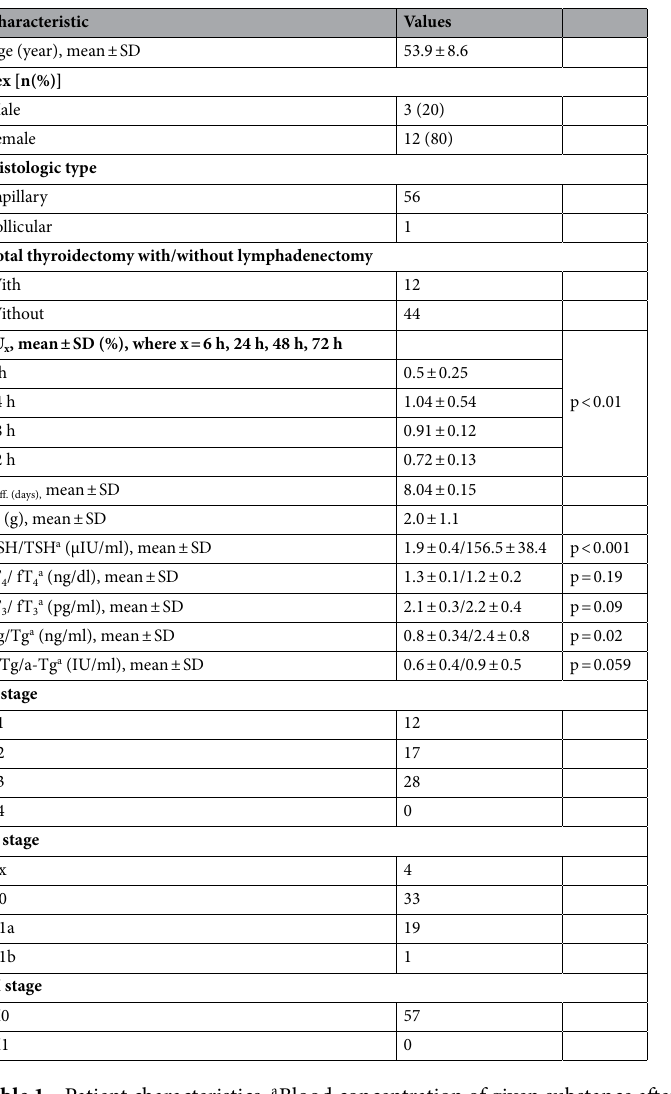
Table 1. Patient characteristics. a Blood concentration of given substance after stimulation with